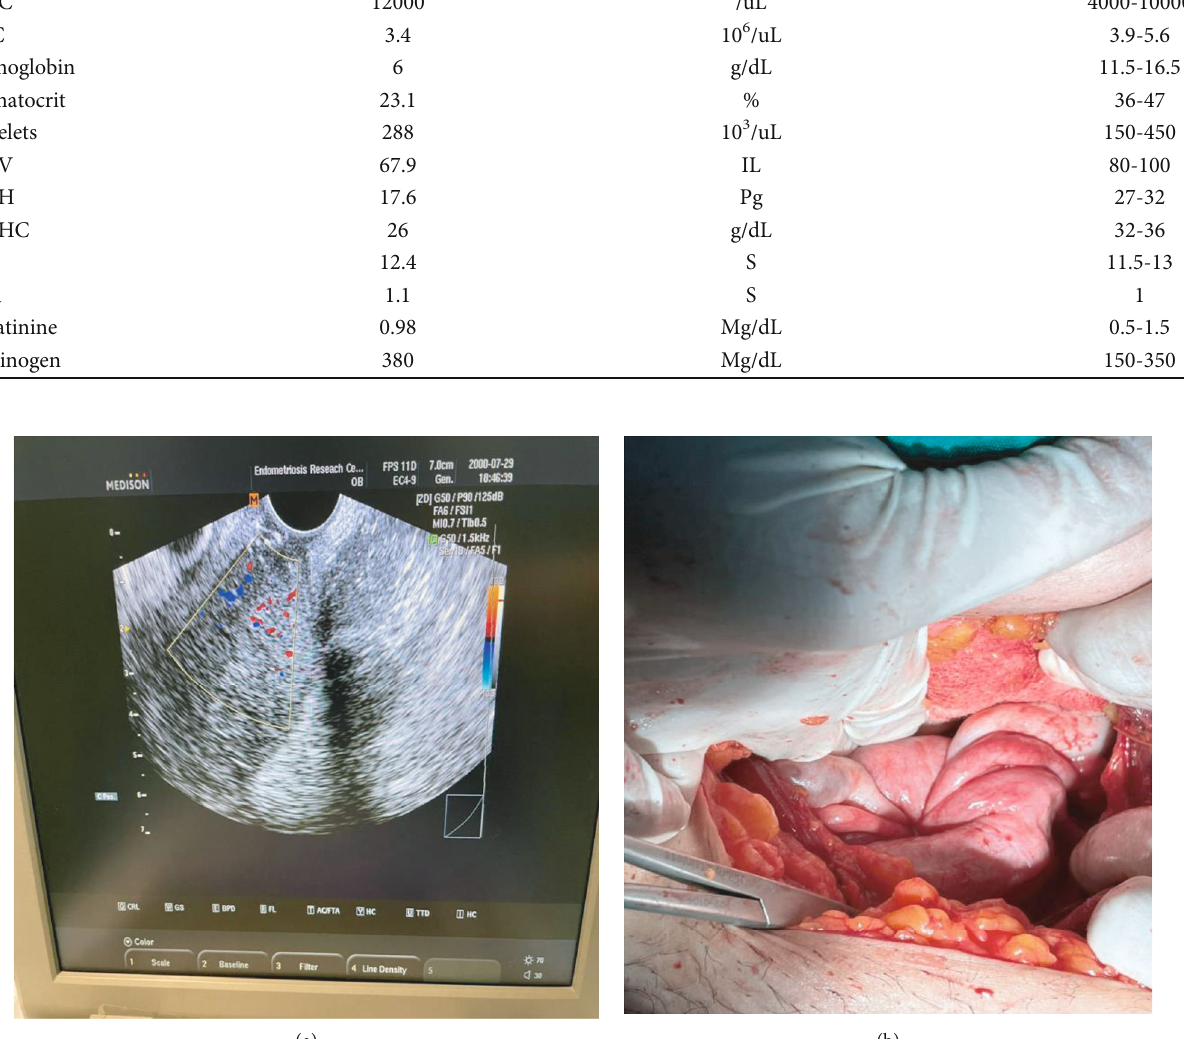
Figure 1: Ultrasound fi ndings indicate the absence of a uterus in the pelvic cavity (a). Con fi rmation of the absence of uterus in the abdominal cavity after abdominal incision (b).